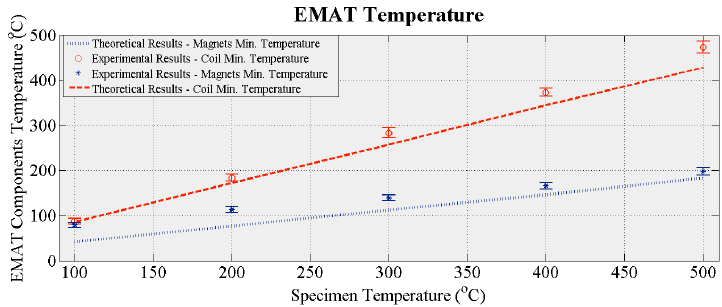
Figure 12. Measured temperature of EMAT coil and magnets vs. temperature.